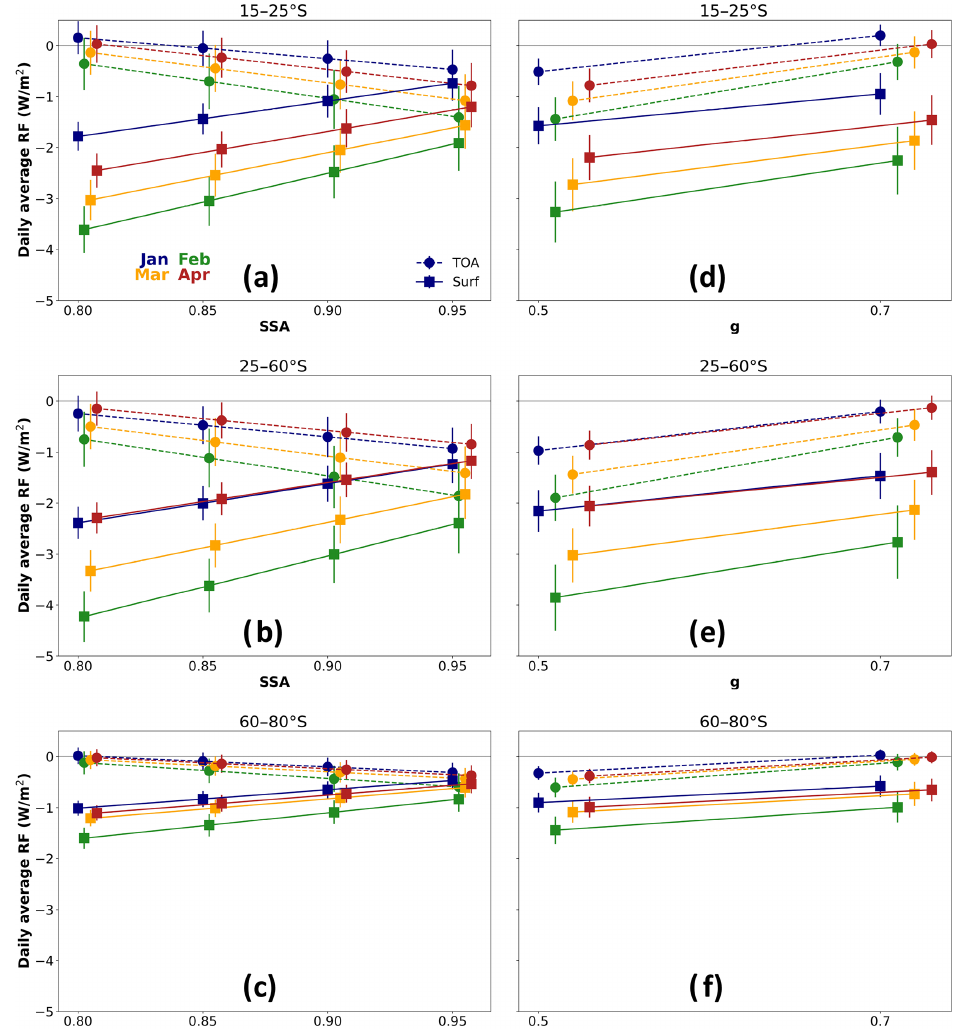
Figure 5. Monthly mean regional equinox-equivalent daily-average RF at the TOA (dots and dashed lines) and surface (squares and solid lines) as a function of the SSA ( a–c for 15–25, 25–60 and 60–80 ◦ S, respectively) and g ( d–f for 15–25, 25–60 and 60–80 ◦ S, respectively). Different months are in different colours: January, blue; February, green; March, yellow; April,